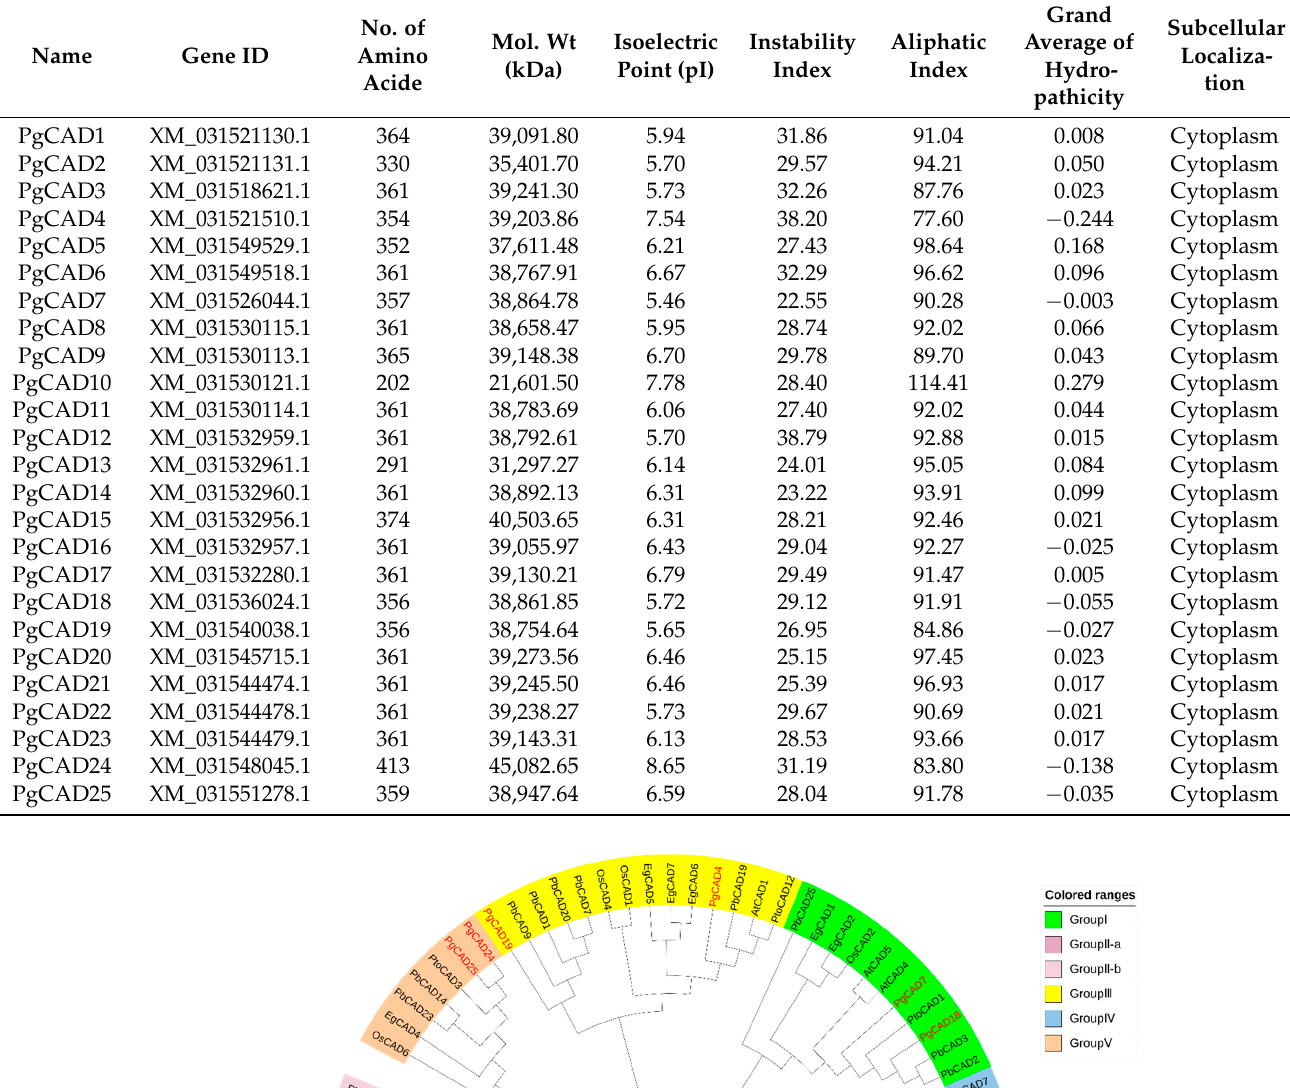
Table 1. The predicated protein information of PgCAD .